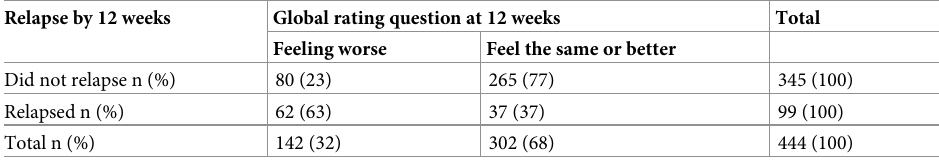
Table 4. Association of relapse measured by rCIS-R and self-reporting feeling worse (GRQ) at 12 weeks.